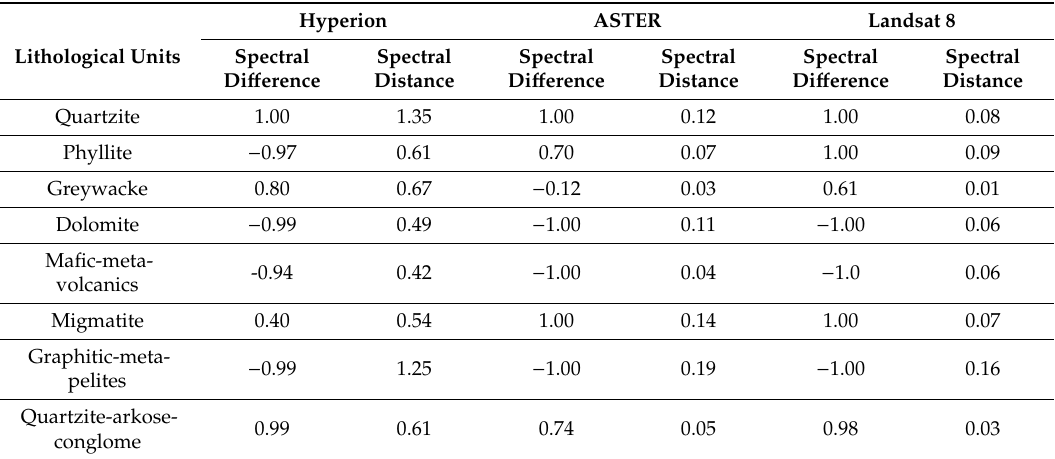
Table 3. Average spectral statistics of the training